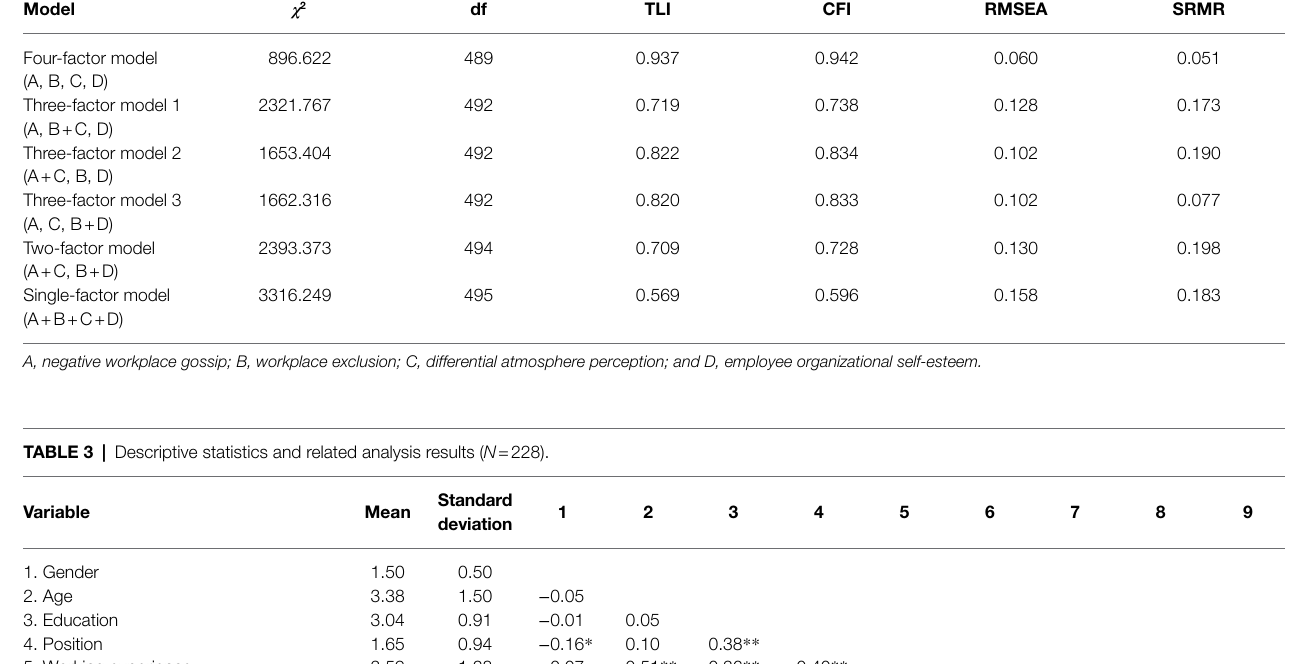
TABLE 2 | Confirmatory factor analysis and comparison ( N = 228).